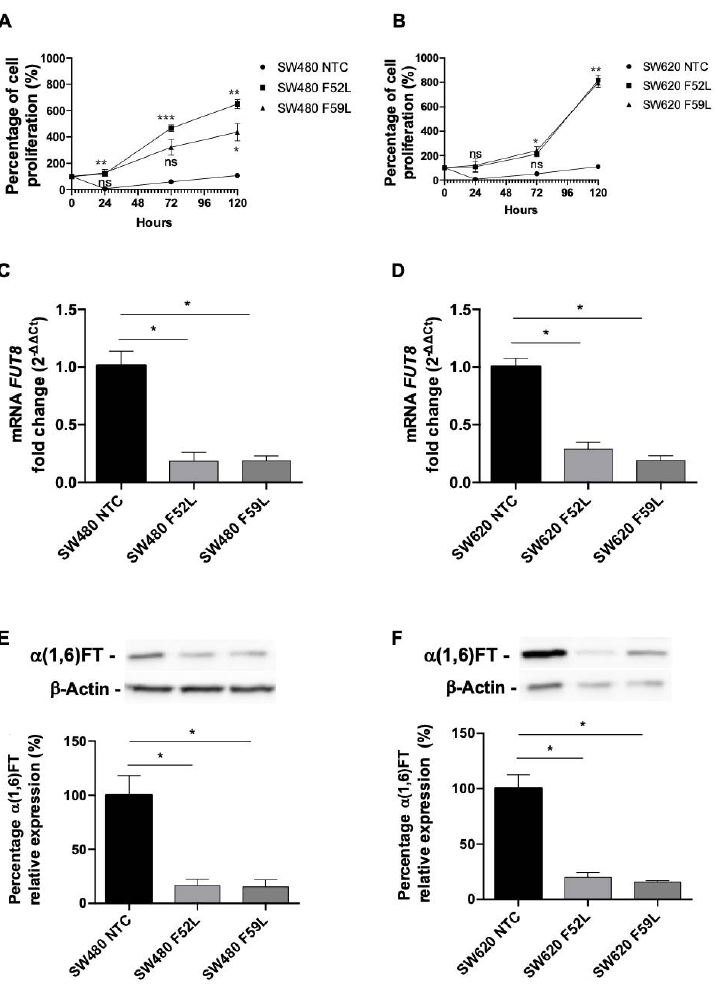
Figure 3. Effect of LCA treatment on SW480 and SW620 FUT8 knockdown clones. ( A , B ): Cell growth dynamics of ( A ) shRNA FUT8 clones of SW480 and ( B ) SW620 treated with 500 µg/mL of LCA in culture medium. Black circles: non-targeted control (NTC) cells; black squares: shRNA FUT8 F52L cells; black triangles: shRNA FUT8 F59L cells. Cell proliferation was measured in triplicate using alamarBlue assay. Results are given as percentage of proliferation, considering basal point for each cell line as 100%. Plots represent mean ± SEM. NTC clones were used as reference for statistical calculations. One-way ANOVA was significant, and multiple comparisons among NTC, F52, and F59 groups were done using Fisher’s multiple comparisons test; * p < 0.05; ** p < 0.01; *** p < 0.001. ( C , D ): mRNA FUT8 levels analyzed by ( C ) RT-qPCR in SW480 and ( D ) SW620 cell models after LCA phenotypic subclone selection. mRNA FUT8 levels were quantified using mRNA GAPDH as housekeeping, and calculated as ∆ Ct. Relative expression between NTC and silenced clones was determined using 2 − ∆∆ Ct fold change method. Measurements were obtained from three experiments, and results were plotted as mean ± SEM. ( E , F ): After lectin selection, Western blot of α (1,6)FT enzyme was performed in ( E ) SW480 and ( F ) SW620 LCA-resistant clones. Measurements were plotted as mean ± SEM of three assays. NTC clones were used for statistical calculations. An unpaired t -test was applied for ( C , D ) mRNA and ( E , F ) α (1,6)FT expression analysis; * p <